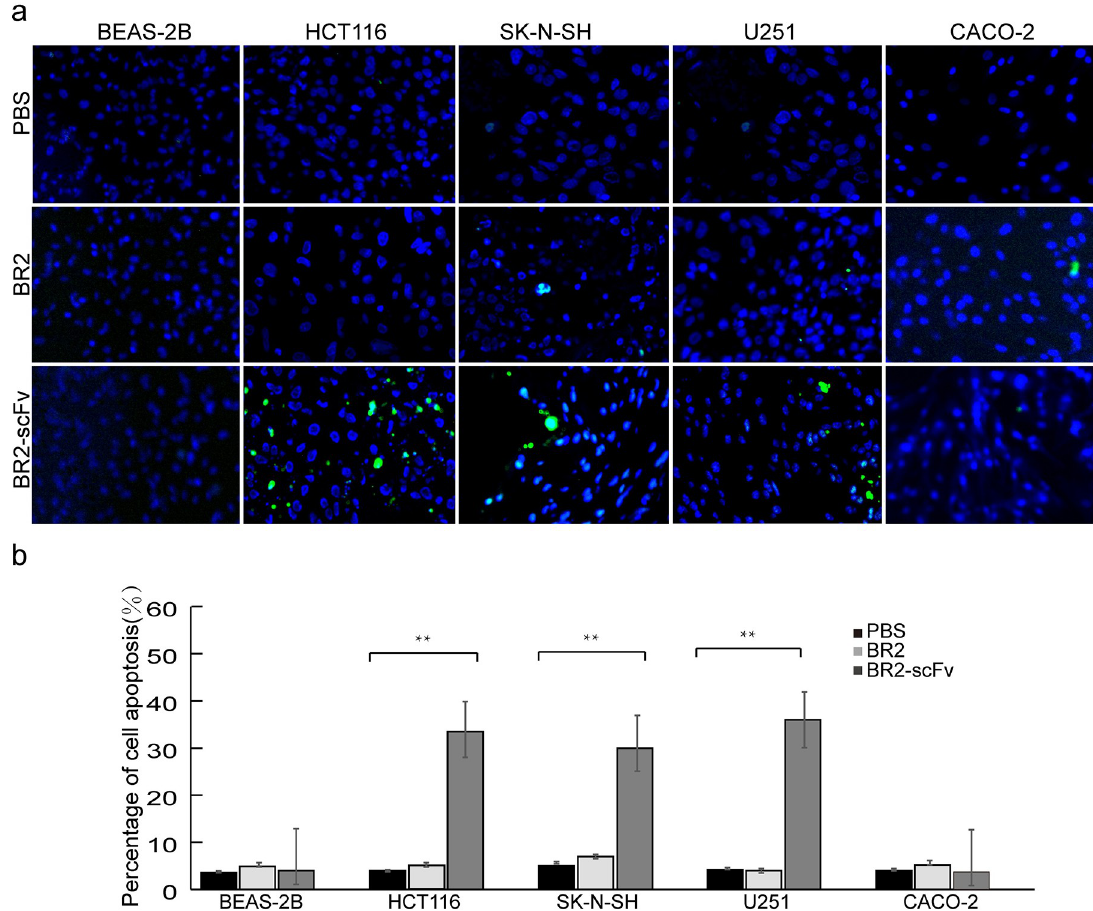
Fig 5. The apoptosis of tumor cells was detected by TUNEL. ( a ) In the normal cell BEAS-2B, almost no apoptotic cell was found in the BR2-scFv treatment group. In HCT116, SK-N-SH and U251 tumor cells the number of apoptotic cells (green fluorescence) in the BR2-scFv group was more than that in the BR2 and PBS groups. ( b ) The percentage of these apoptotic tumor cells in the BR2-scFv group was higher than that in the BR2 and PBS